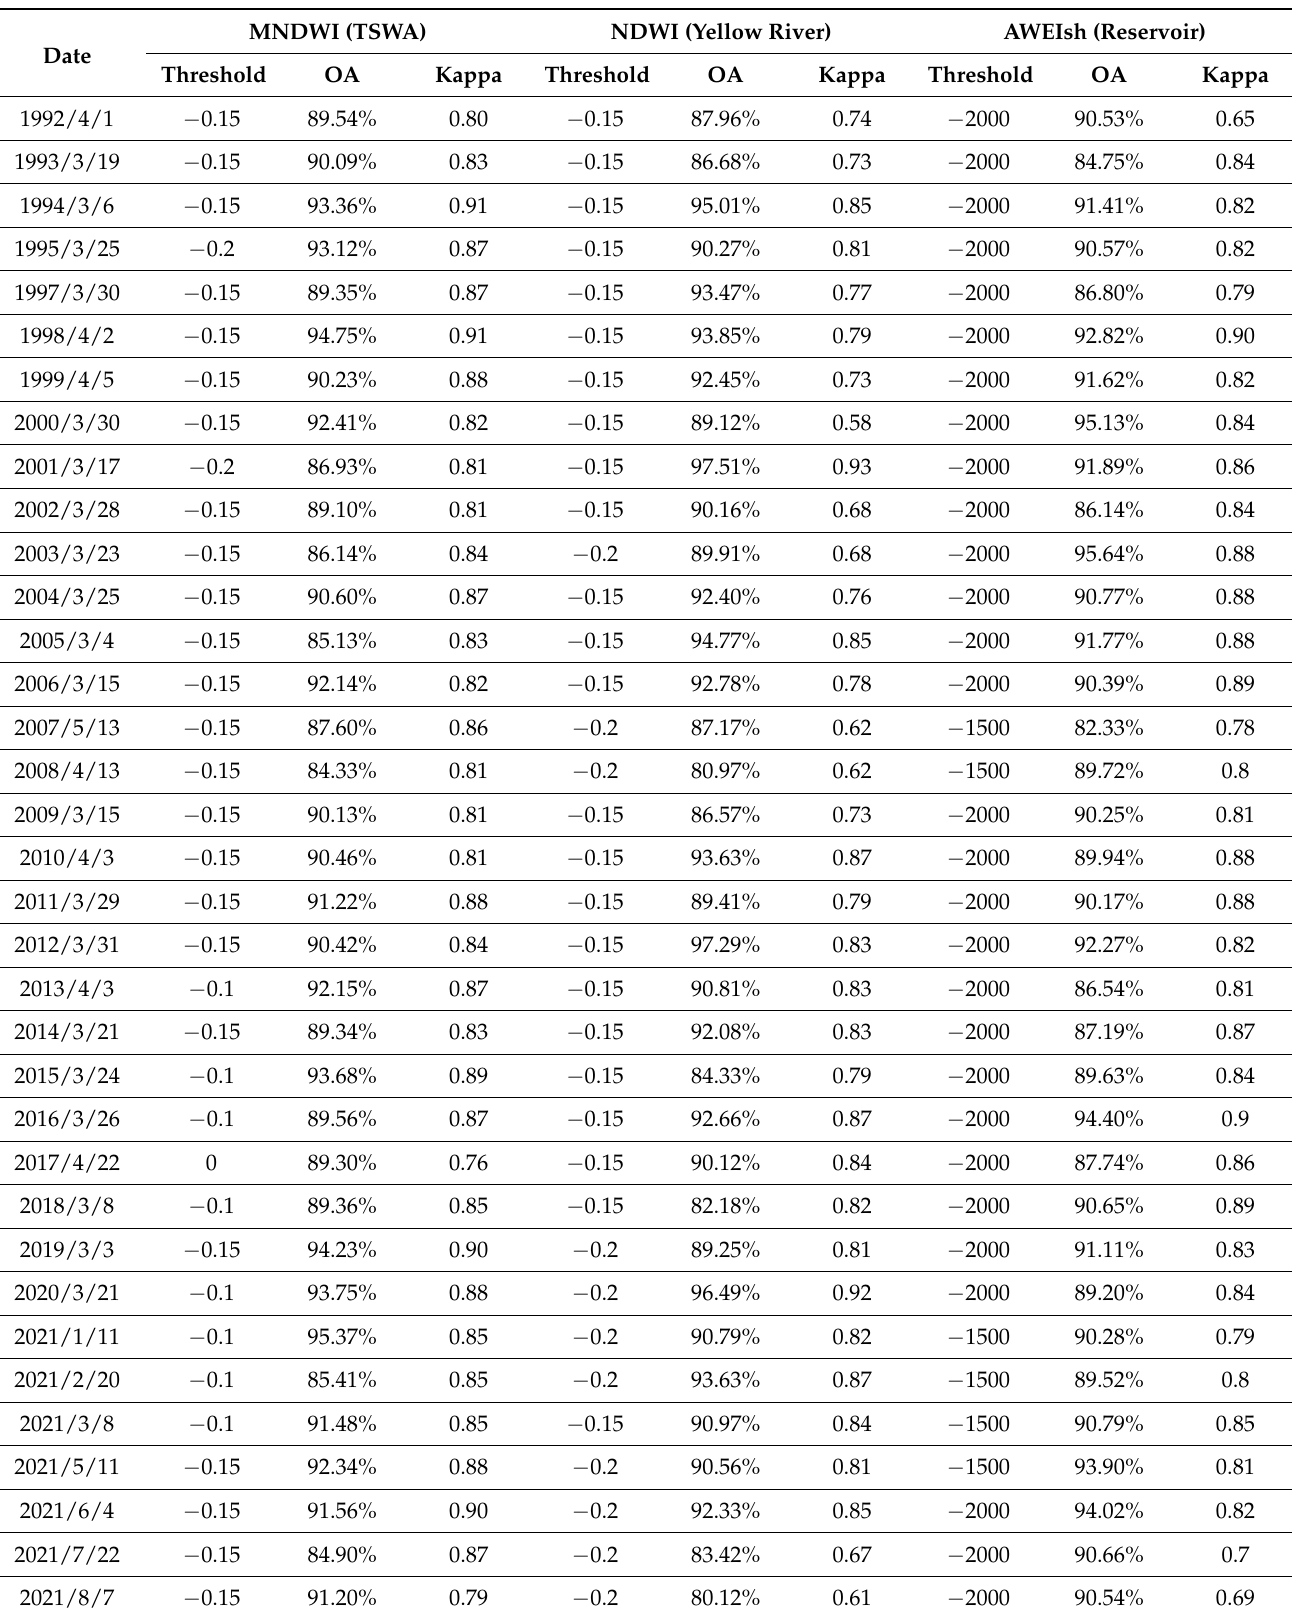
Table 6. The optimal threshold and precision of time